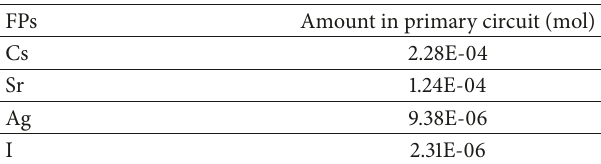
Table 10: Accumulation of FPs in the primary circuit 24 h after an accident.